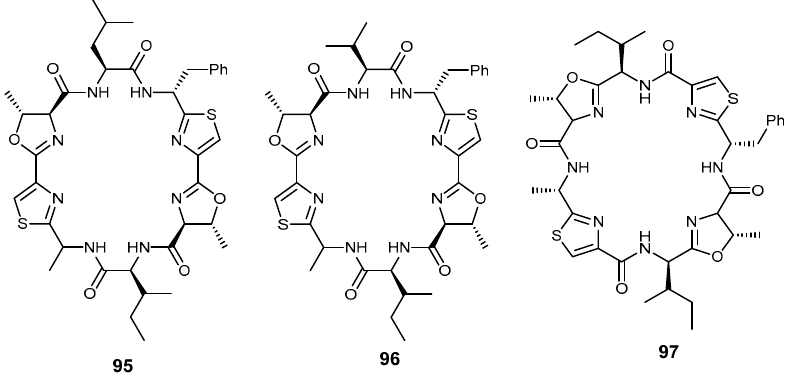
Figure 20. Structures of patellamides B ( 95 ), C ( 96 ), and D ( 97 ).